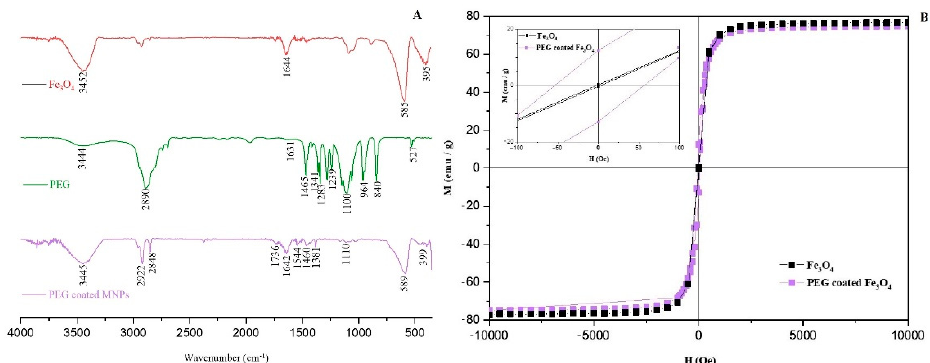
Figure 5. ( A ) FTIR spectra of MNPs, PEG and PEG-coated MNPs ( B ) Magnetic behavior of MNPs. The hysteresis loop shows a slight decrease in the magnetization behavior after a thin PEG layer coating. The magnetic hysteresis loops of mesoporous MNPs at 300 K. Inset within Figure 5 ( B ) shows the magnetic coercivity H c = 53.3 Oe.